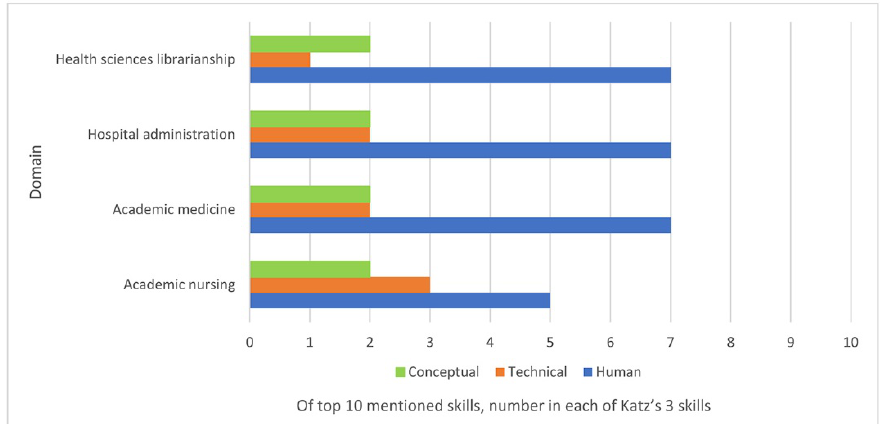
Figure 2 Leadership skills mapped to Katz three skills